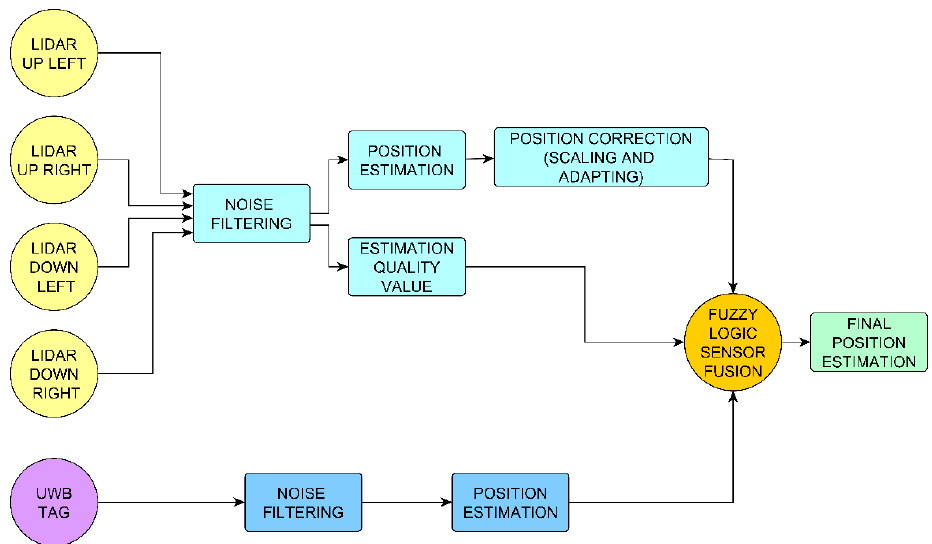
Figure 2. Conceptual diagram of the sensor fusion strategy based on fuzzy logic used for the posi- tion estimation.